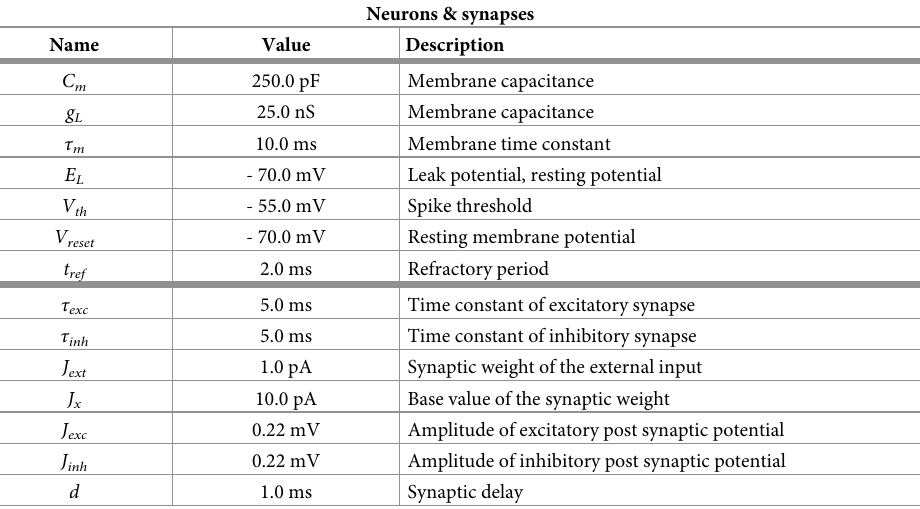
Table 1. Parameter values for the neurons (top) and for the synapses (bottom) in both network models. Neurons &